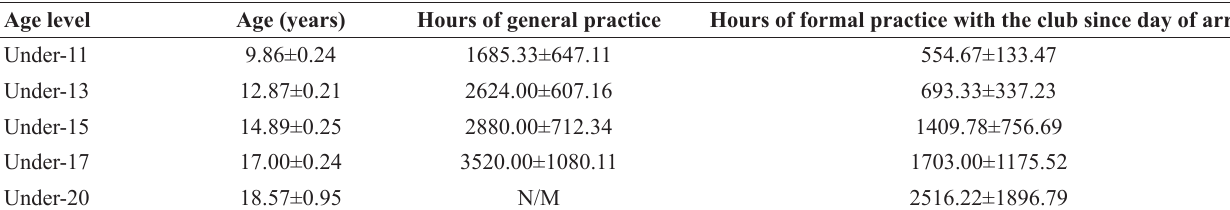
Table 1. Mean ± standard deviation (SD) of age and hours of practice for each age level. Age level Hours of formal practice with the club since day of arrival